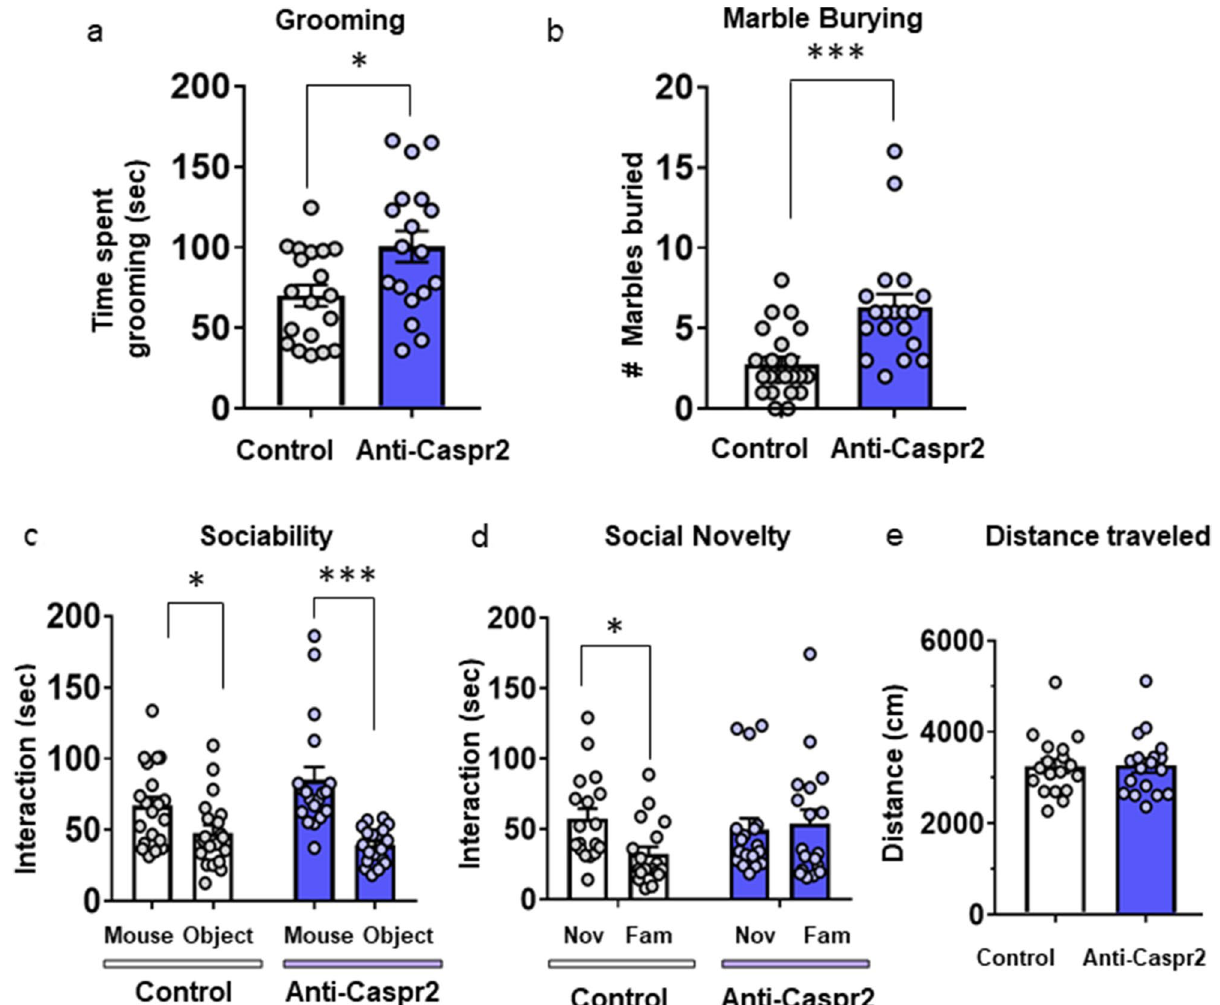
Figure 4. Behavioral phenotype of male mice born to dams harboring anti-Caspr2 IgG. ( A ) Grooming. Time spent grooming was recorded during two independent 15 min sessions and scored automatically using Ethovision software. Male mice born to Caspr2 immunized dams (Anti-Caspr2) spent overall more time grooming than male mice born to Control dams (Control). Control n = 19, Anti-Caspr2, n = 18, t-test, t(35) = 2.628, * P < 0.05. ( B ) Marble burying task. Anti-Caspr2 male mice buried more marbles than Control. Control, n = 22, Anti-Caspr2, n = 19, Mann Whitney, U = 66.5. *** P < 0.0001 ( C ) Sociability test. Control and Anti-Caspr2 offspring displayed a normal sociability defined as spending more time sniffing a mouse compared to an object. Control n = 20, Anti-Caspr2, n = 19. Two way repeated measures ANOVA, Immunization x Sociability Interaction: F (1, 37) = 7.828, P < 0.05, followed by Bonferroni post hoc test * P < 0.05, *** P < 0.0001. ( D ) Social Novelty test. Control offspring displayed a normal social novelty defined as spending more time sniffing a novel (Nov) mouse compared to a familiar (Fam) mouse, whereas offspring from Caspr2 immunized mice spent a similar time sniffing the two mice. Control n = 18, Anti-Caspr2, n = 18. Two way repeated measures ANOVA, Immunization × Novelty Interaction: F (1, 34) = 5.508, P < 0.05, followed by Bonferroni post hoc test * P < 0.05. ( E ) Distance traveled during the social Novelty test. Control and Anti-Caspr2 offspring did not show differences in total distance traveled during the social preference test Control n = 18, Anti-Caspr2, n = 18. t-test, t (34) = 0.07608, n.s. ( A – E ) Control, 9 litters, Anti-Caspr2, 7 litters, from two independent experiments. * P < 0.05, *** P < 0.001. Mean ±